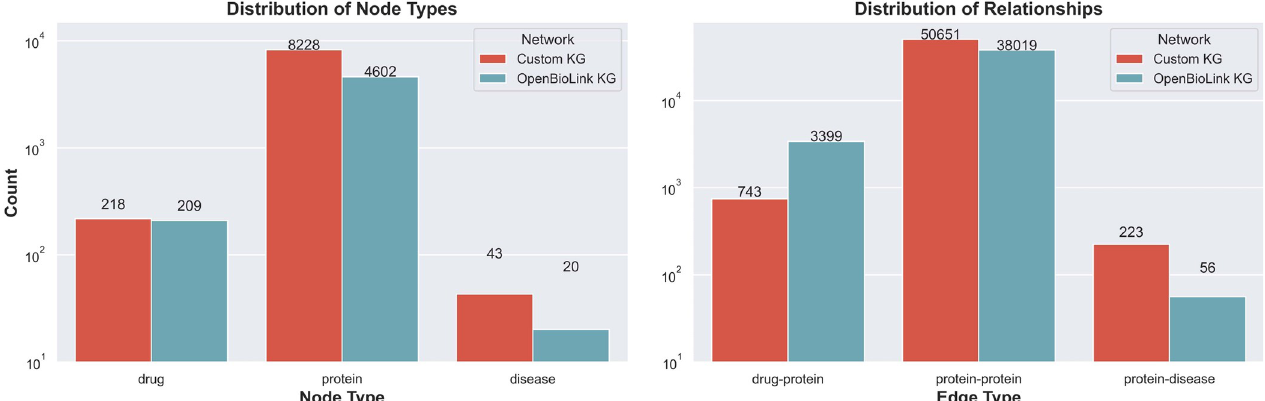
Fig 4. Distribution of node and edge types in the custom and OpenBioLink KGs. The properties of each of the two networks are detailed in S7 Table .